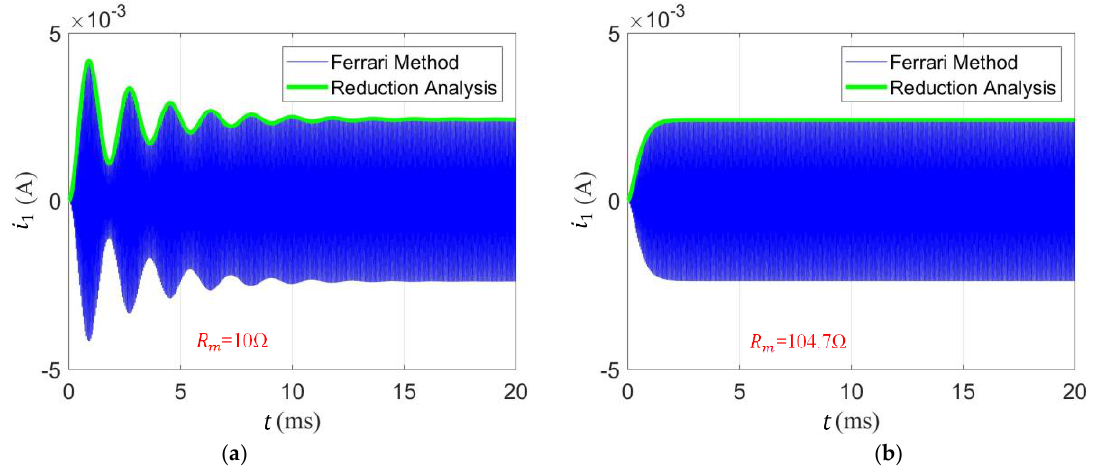
Figure 4. Comparison of the Ferrari method and the reduction analysis for underdamped ( a ) and critically damped ( b ).